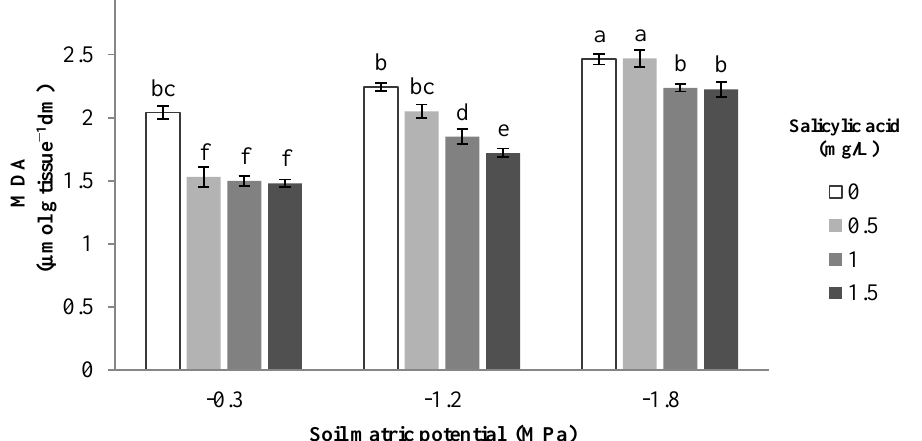
Figure 1. Mean comparisons for the interaction effects of controlled water stress and foliar application of SA on MDA concentration of